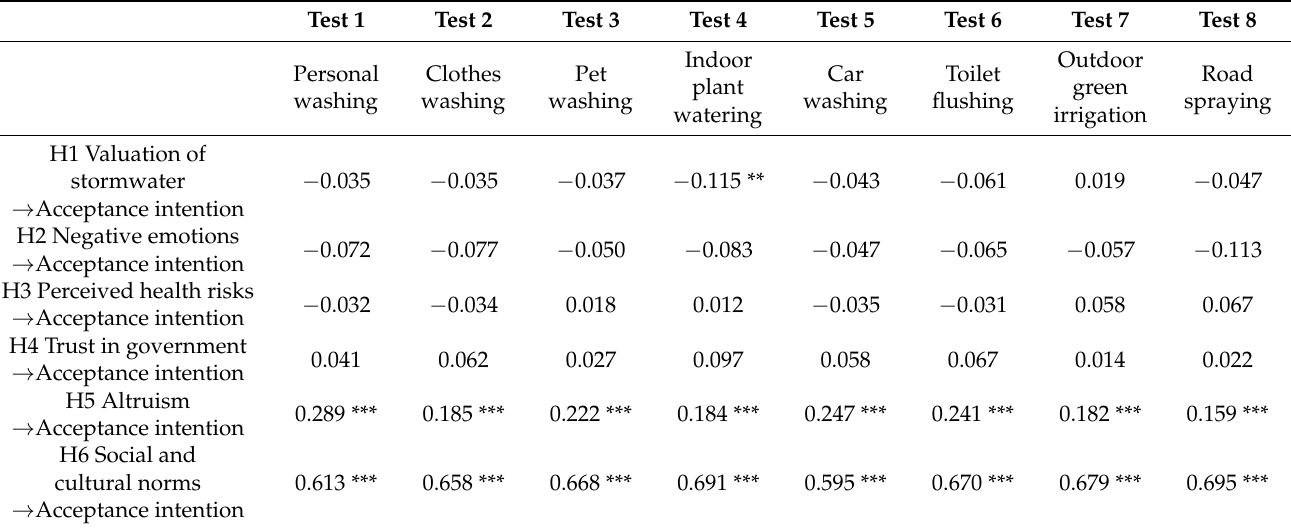
Table 4. Standardized path coefficients for structural equation